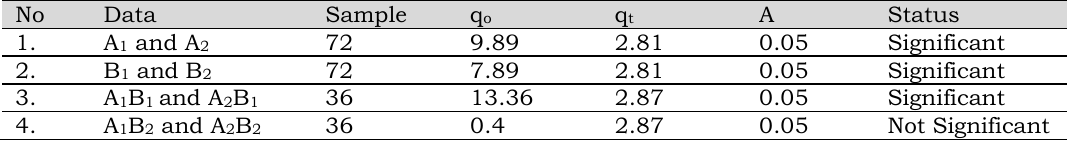
Table 11. The result of Tukey’s HSD